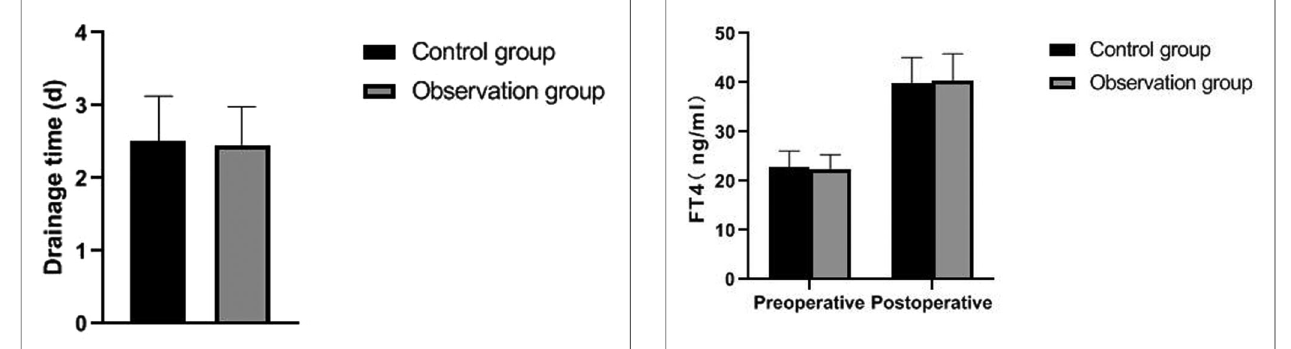
FIGURE 6 | Comparison of FT4 levels between the two groups.